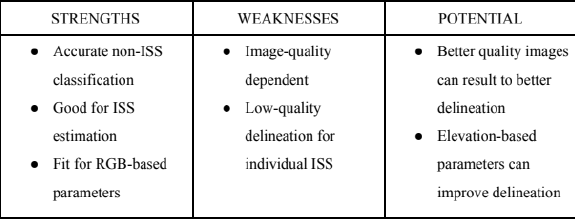
Table 9. Summary of the strengths, weaknesses, and potential of the